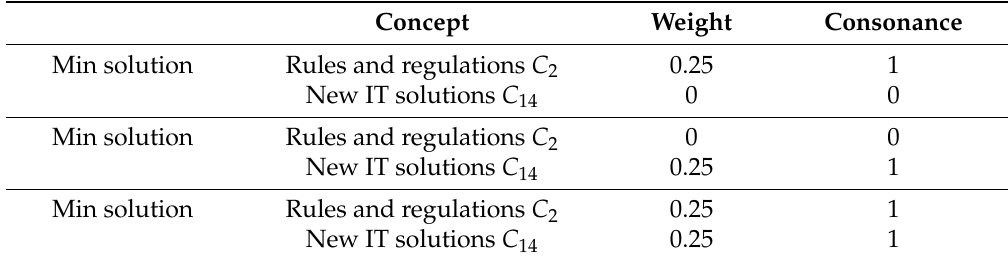
Table 13. Maximum and minimum solution for the fuzzy cognitive map determining the work of the banking